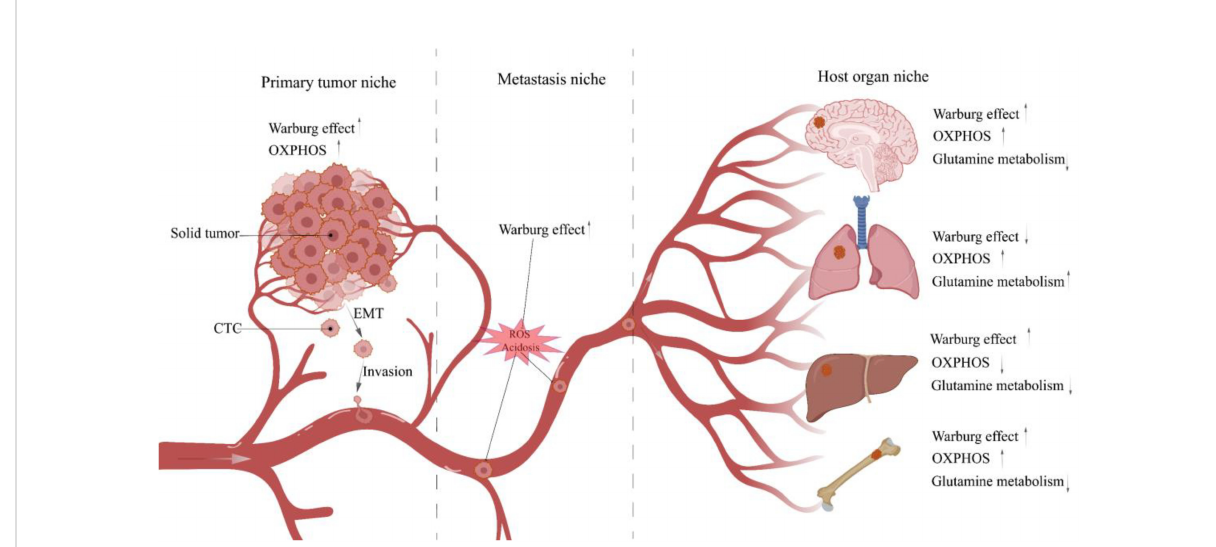
FIGURE 3 Metabolic characteristics of TNBC cells in different niches. When tumor cells leave the tumor bed and begin the metastasis process, they will traverse multiple niches with diverse microenvironments. Different microenvironments impose distinct survival restrictions, and tumor cells must change their metabolic pathways dynamically to resist these pressures. CTC, Circulating tumor cell; EMT, Epithelial-mesenchymal